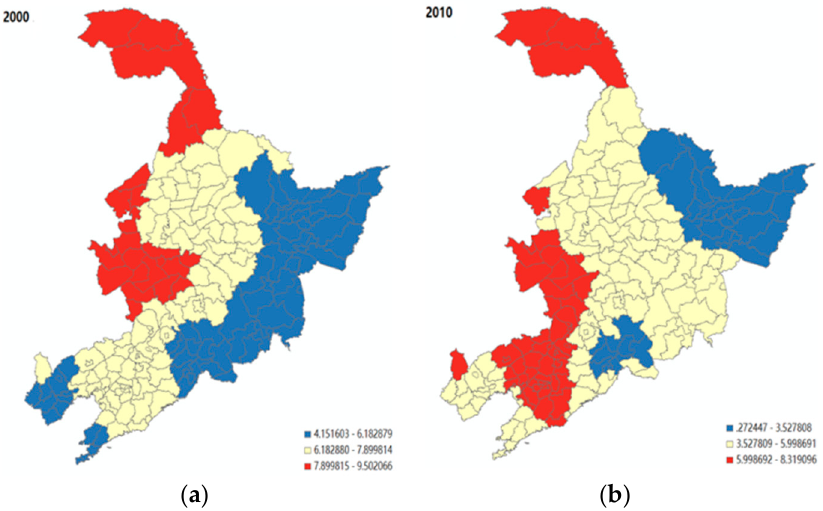
Figure 5. The spatial variability of the effect of mortality on population ageing. ( a ) Year 2000; ( b ) Year 2010.